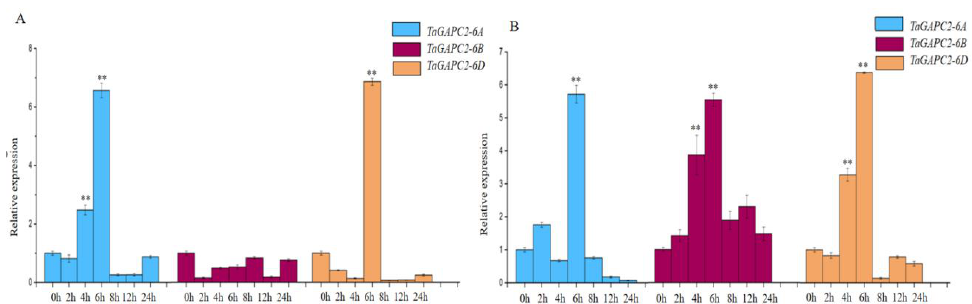
Figure 1. Transcription profiles of TaGApC2 in Chinese spring wheat leaves under 20% PEG8000 ( A ) and 10 mM H 2 O 2 ( B ). The β-actin gene was used as an internal reference. The vertical ordinate is the fold change; the horizontal ordinate is the treatment time. The data represent three independent experiments. The standard deviation (SD) is indicated at each point. Significant differences were assessed by one-sided paired t -tests (** p < 0.01).